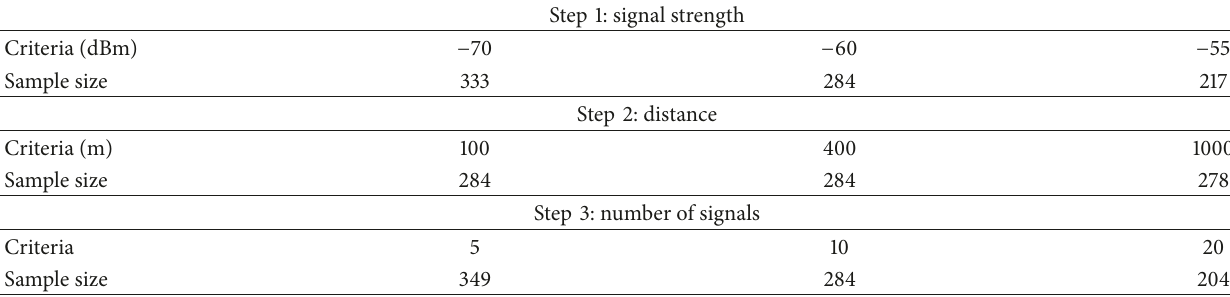
Table 2: Sensitivity of the final sample size to the screening